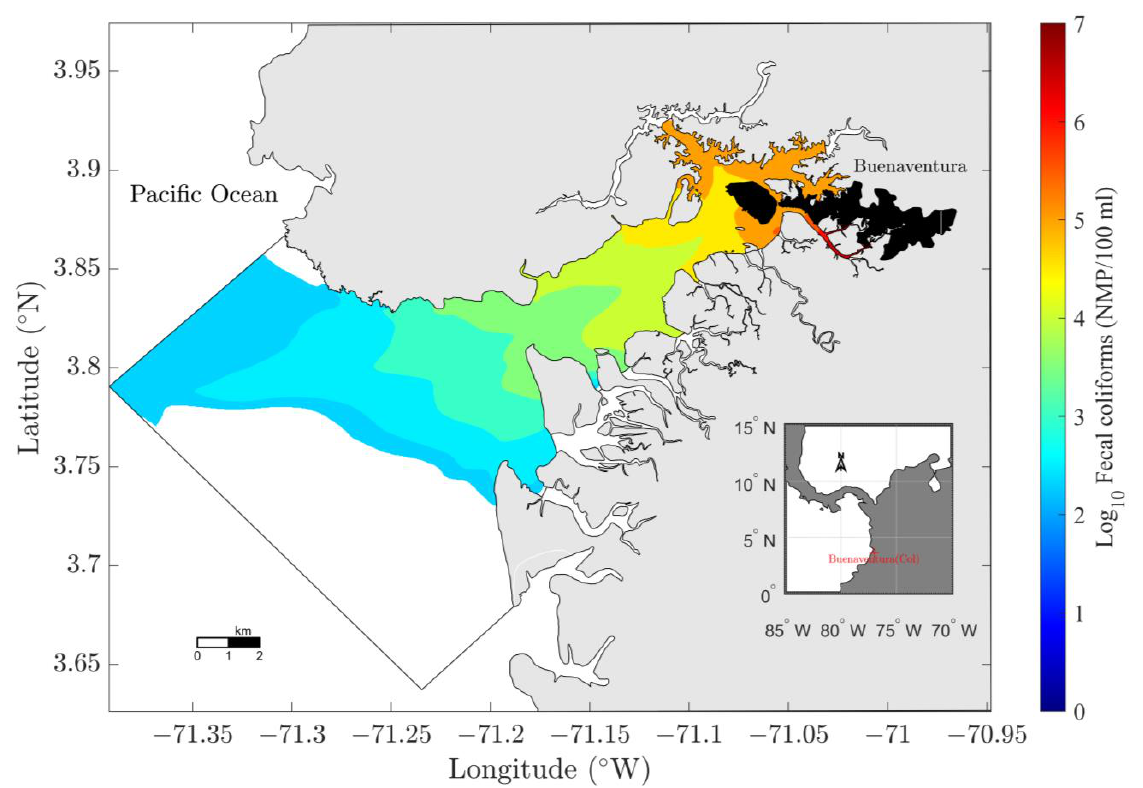
Figure 16. Spatial distribution of the maximum fecal coliform concentration in Buenaventura Bay in scenario five.